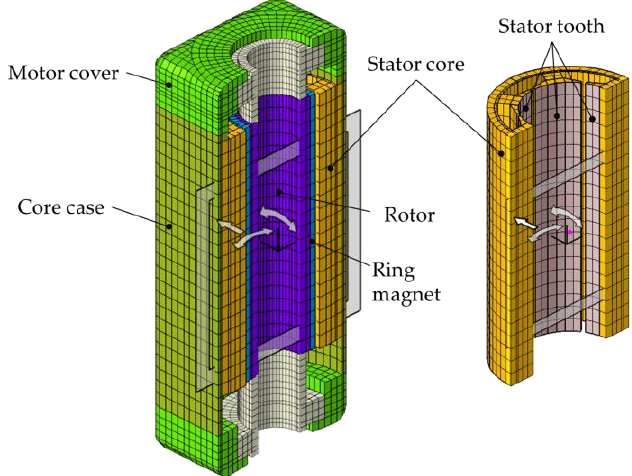
Figure 5. BLDC 3D model half-cut view for noise simulation.